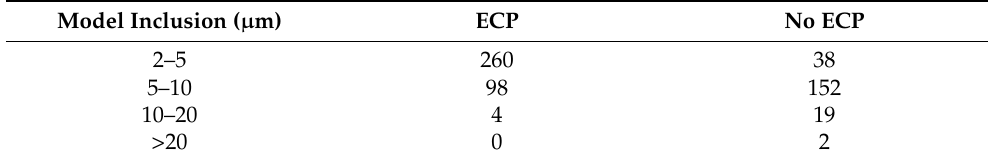
Figure 5. Microscopic analysis of inclusions in the sample without electrification and after electrifica- tion treatment. ( a ) Microscopic analysis of the inclusions inside the sample after no electrification treatment. ( b ) Microscopic analysis of inclusions inside the sample after electrification treatment. Table 2. Statistical analysis of inclusion size with and without electric field.